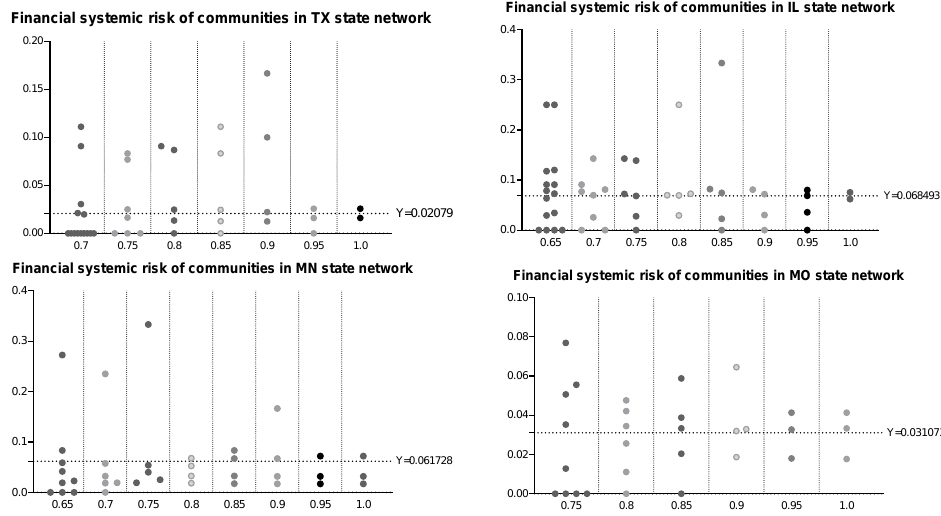
Figure 8. Comparison of the systemic risk of different communities of four